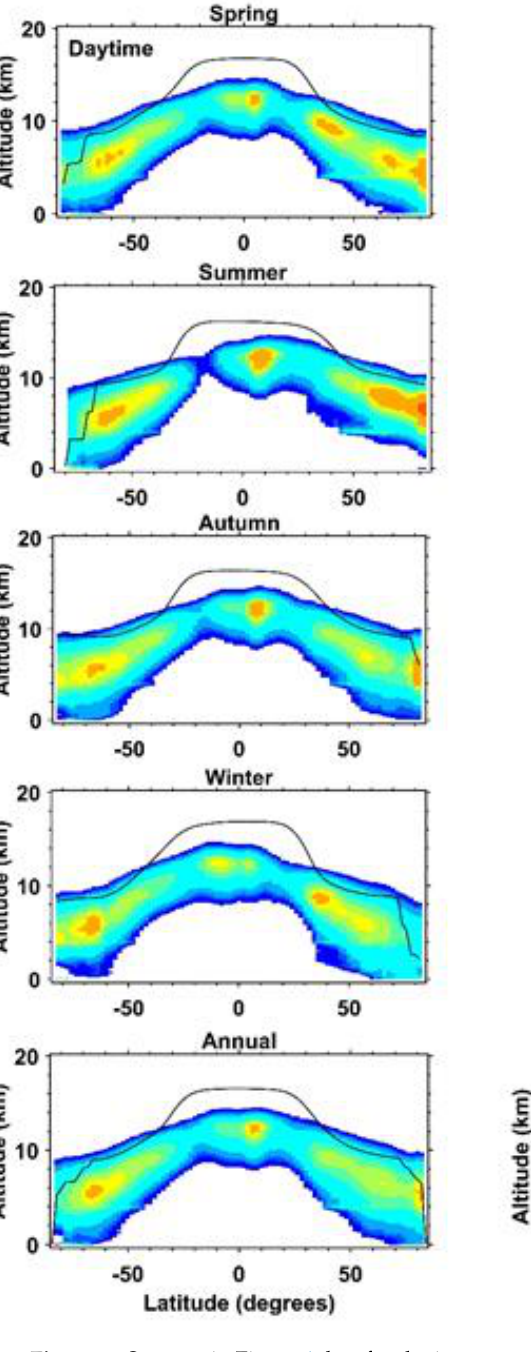
Figure 2. Same as in Figure 1, but for the ice water content (IWC). The white color represents the value of less than 0.0005 g/m 3 .